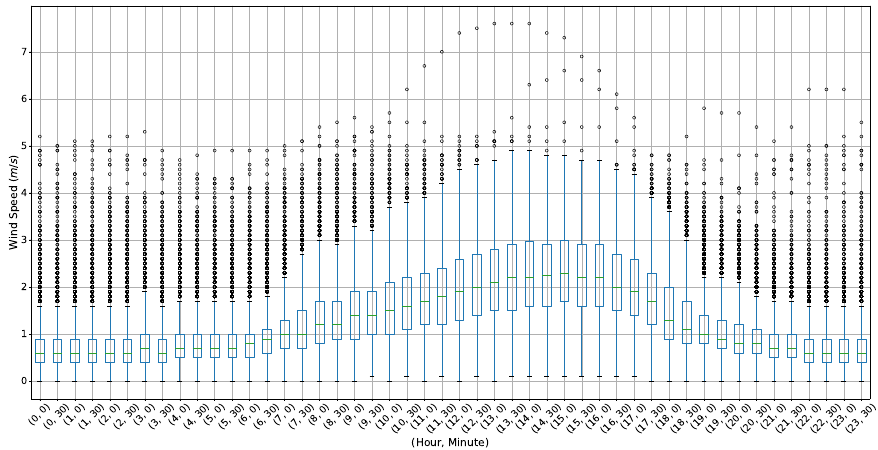
Figure 6. Boxplot of wind speed for every intraday timestep from 2007 to 2019.